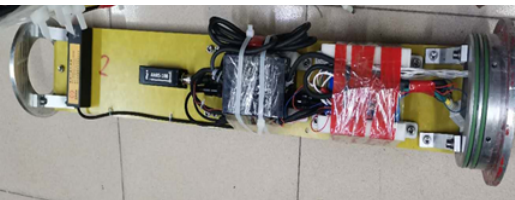
Figure 3. Photo of the experimental equipment with one three-axis fluxgate magnetic sensor.